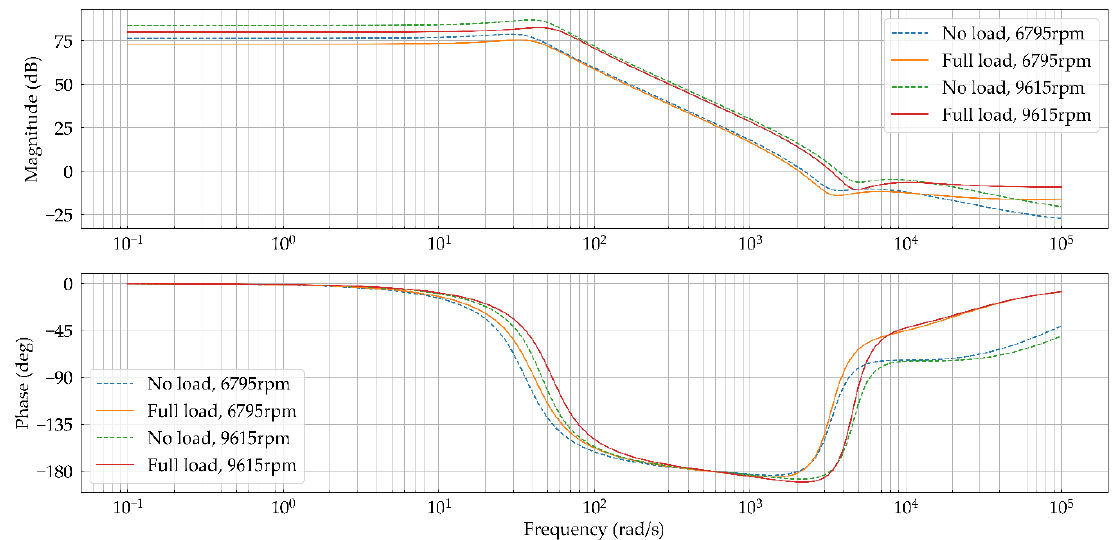
Figure 6. Bode plots of the brushless synchronous generator at different operating points.